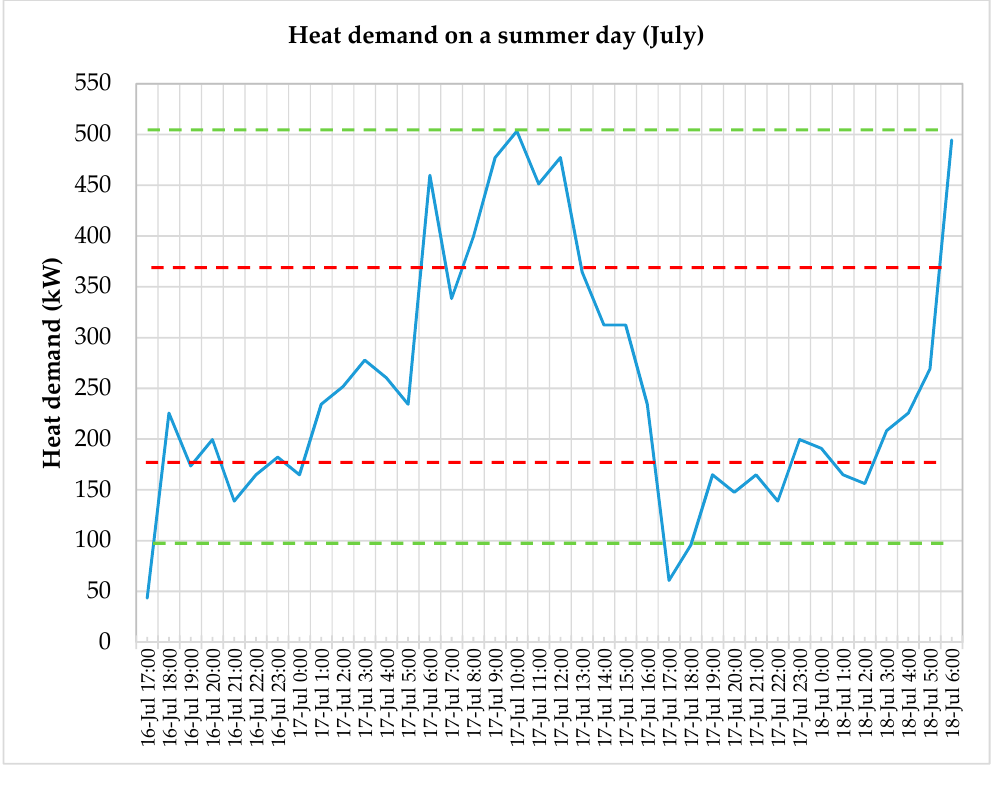
Figure 15. Heat demand on a summer day (July).